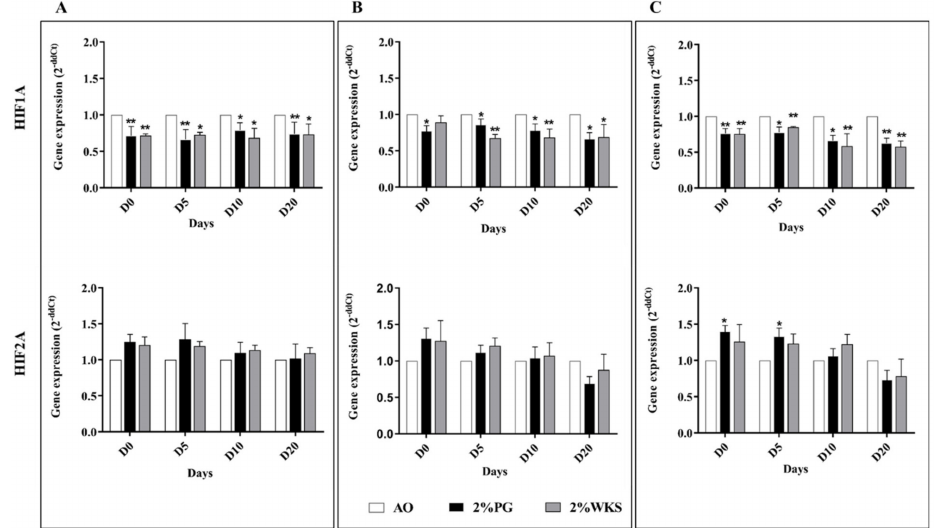
Figure 8. Gene expression of HIF1A and HIF2A in. ( A ) SHEF1, ( B ) SHEF2, and ( C ) ZK2012L. The RT-qPCR expression of the HIFs normalized to the expression of internal control ACTB. Y -axis shows the relative changes in 2 − ∆∆ CT of air oxygen exposed cells to physoxia cultured cells. The X -axis indicates time (days). Data are presented as a mean ( n = 3), * p < 0.05, ** p <